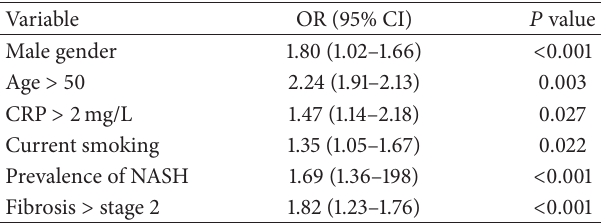
Table 2: Multivariate analysis for the risk for hyperplastic polyp by gender, age, smoking, CRP level, prevalence of NASH, and the degree of liver